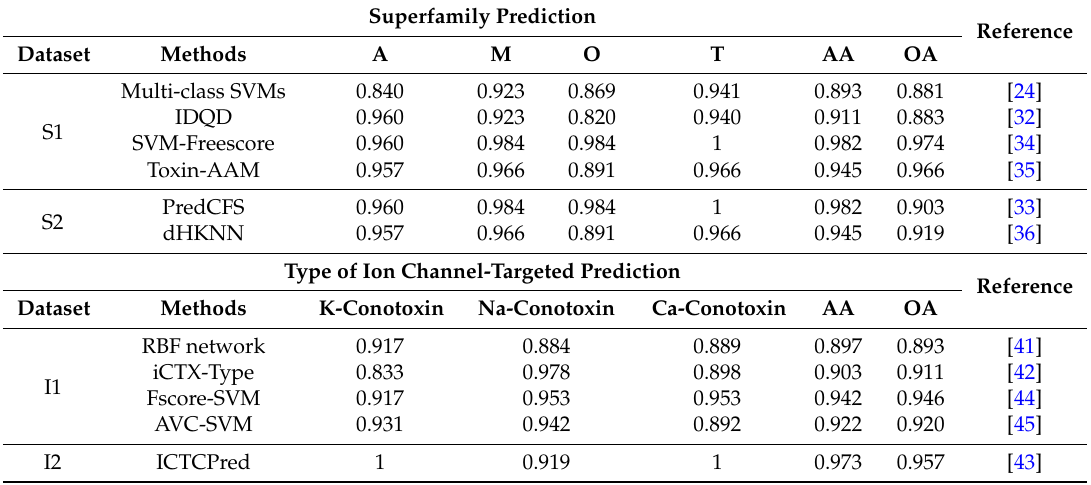
Table 2. A list of published results for conotoxin superfamilies and ion channel-targeted conotoxin classifications.